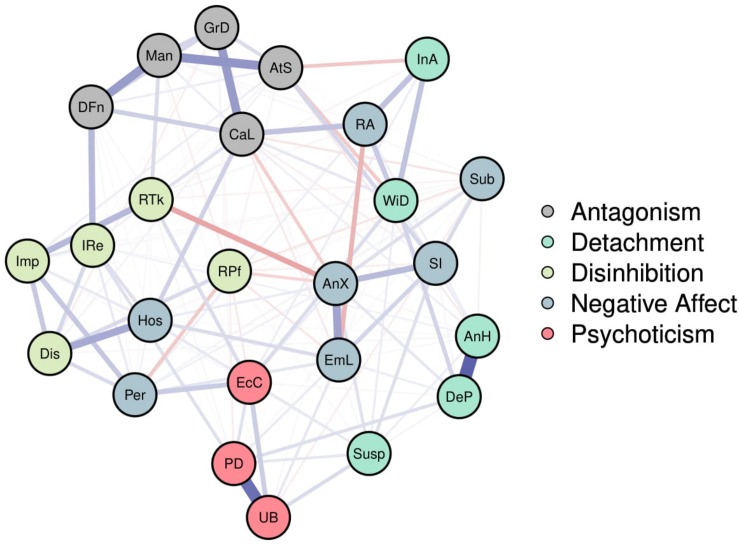
Network of the 25 PID-5-SF facets. Facets belonging to the same domain appear in the same color. Purple (solid) edges represent positive partial correlations between facets, while red (dotted) edges represent partial correlations.